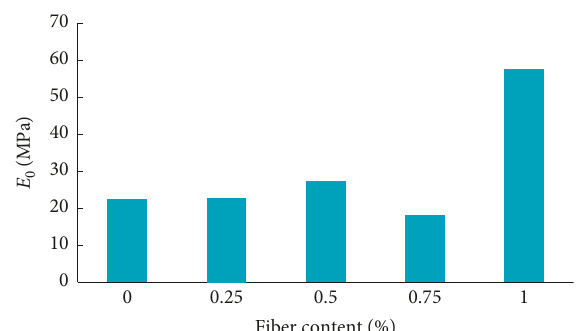
Figure 18: Initial elastic modulus E